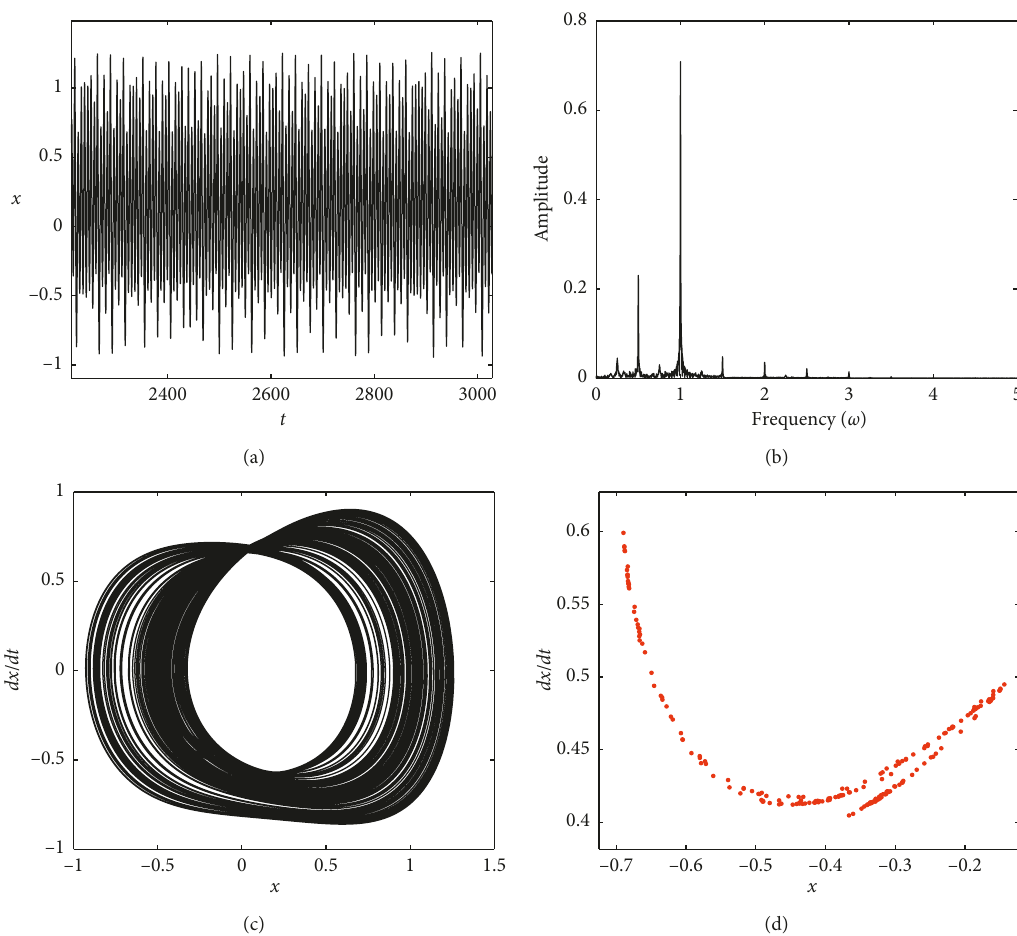
Figure 14: System response at ω � 1rad/s and F � 1N: (a) time history; (b) frequency spectrogram; (c) phase portrait; (d) Poincare maps.